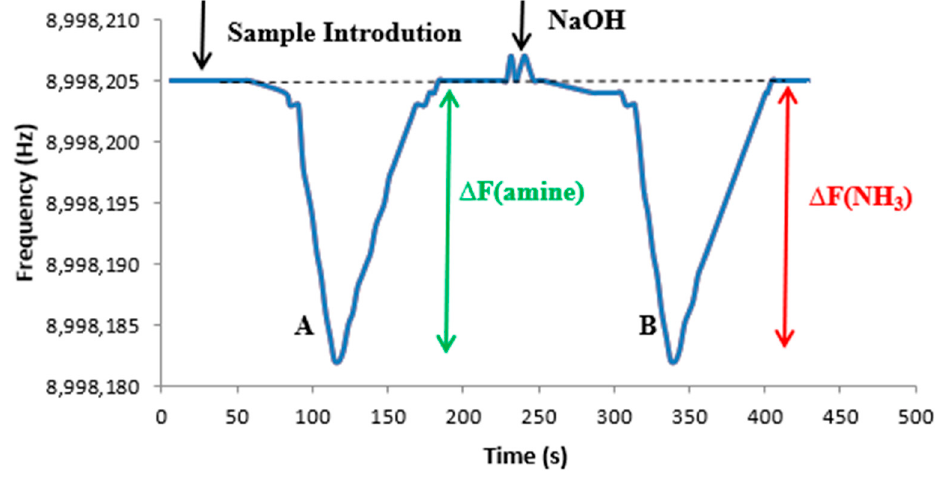
Figure 7. Frequency of the sensor during the analysis of a solution 1.8 µmol L − 1 in ammonia and 1.8